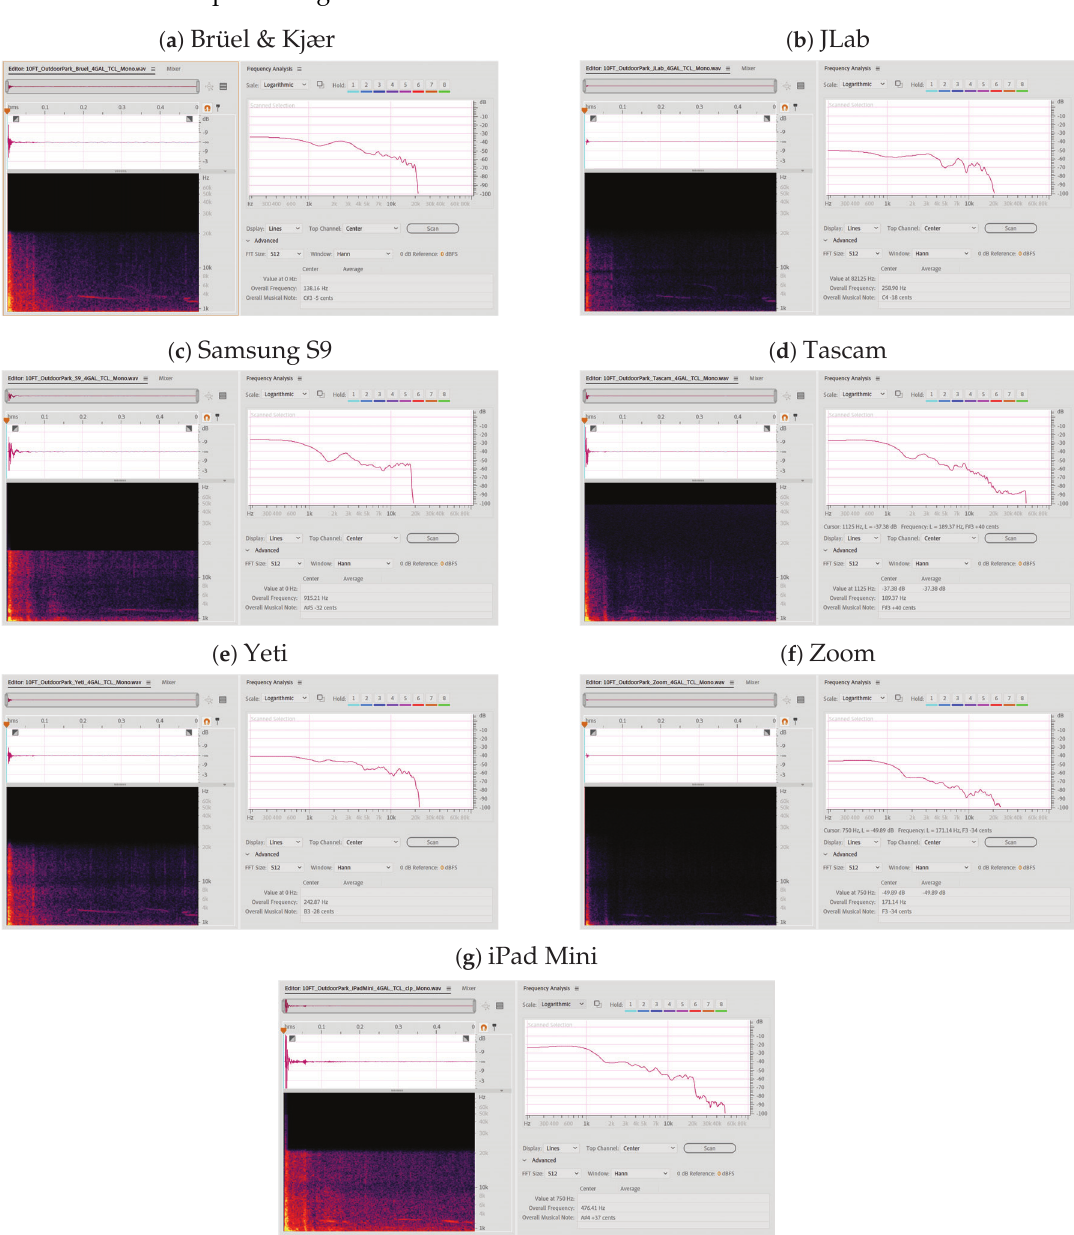
Figure 5. Spectrogram plots with the frequency response for the 15.14 liters bag at 304.80 cm from the various microphones in the outdoor